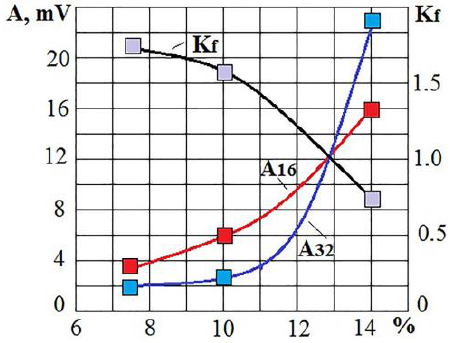
Figure 11. Change in RMS amplitude in octaves of 16 and 32 kHz and the K f parameter depending on the percentage of the area covered by intermetallic compounds.